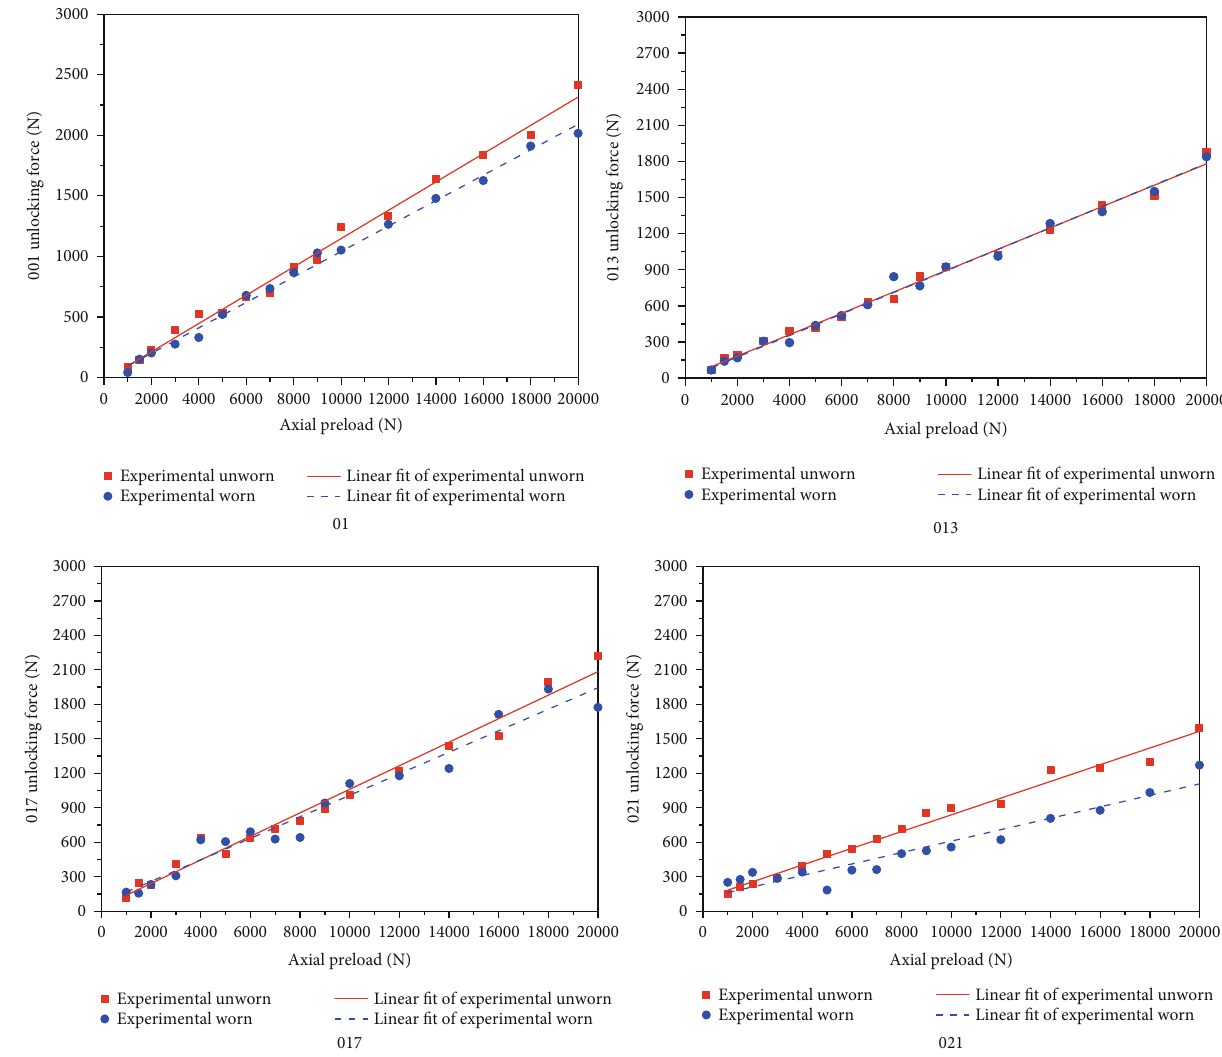
Figure 15: Various types of fi nger lock unlocking force and axial preload